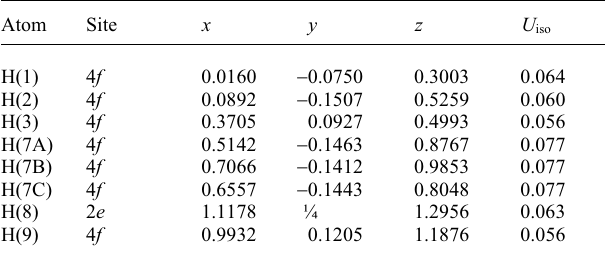
Table 2. Atomic coordinates and displacement parameters (in Å 2 )